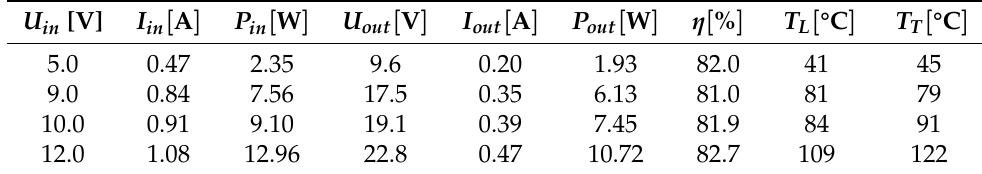
Table 4. Measurement results of the boost